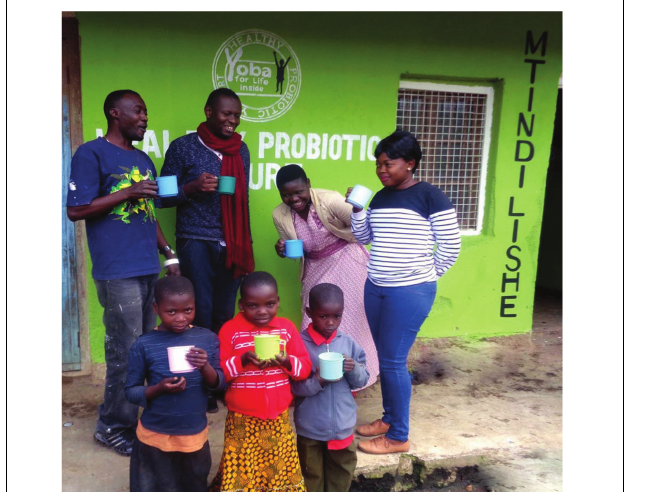
FIGURE 1 | People enjoying Yoba outside a production unit in Tanzania.